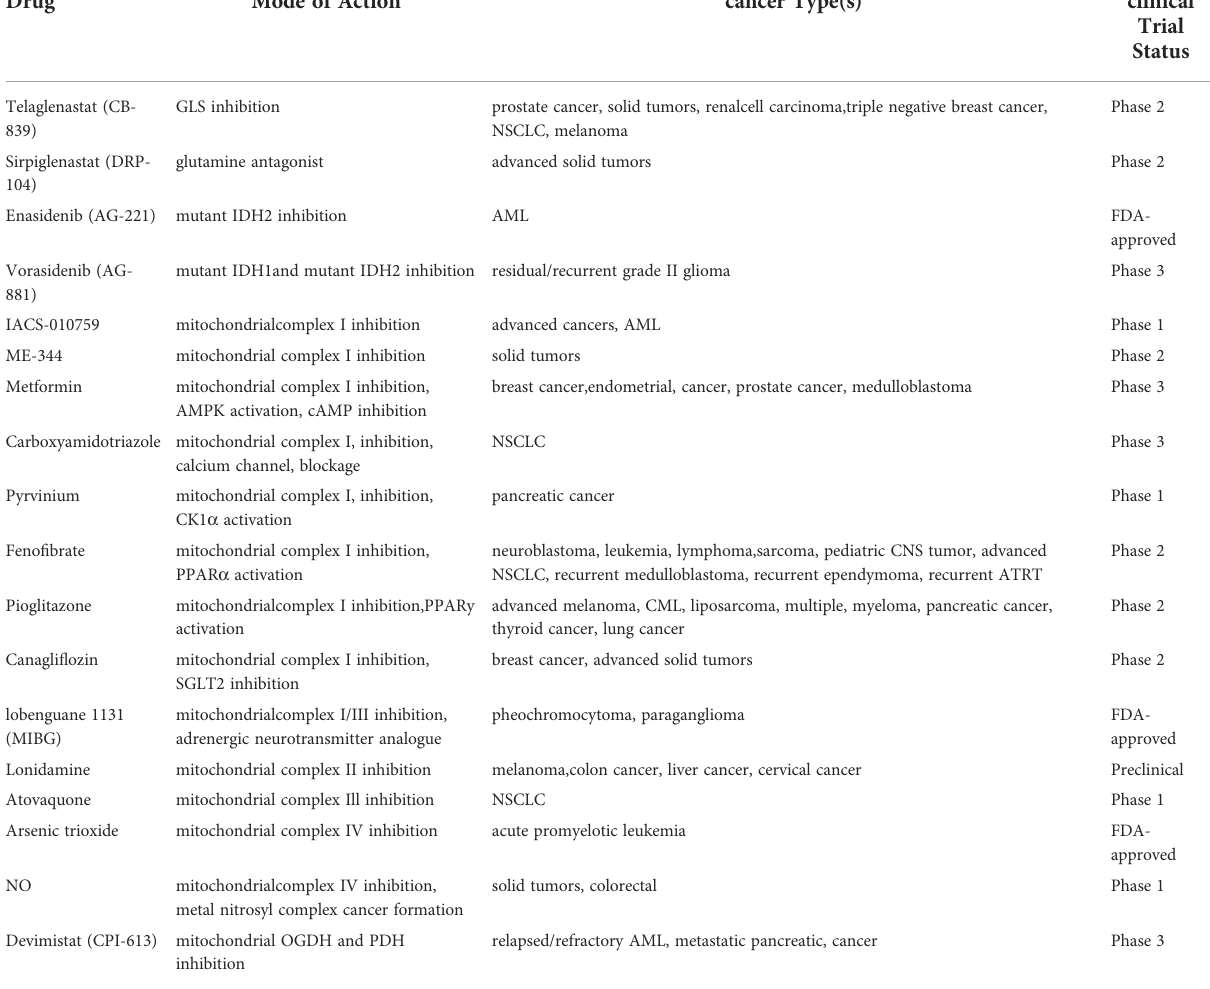
TABLE 1 List of mitochondrial metabolic inhibitors undergoing trial for cancer therapy.